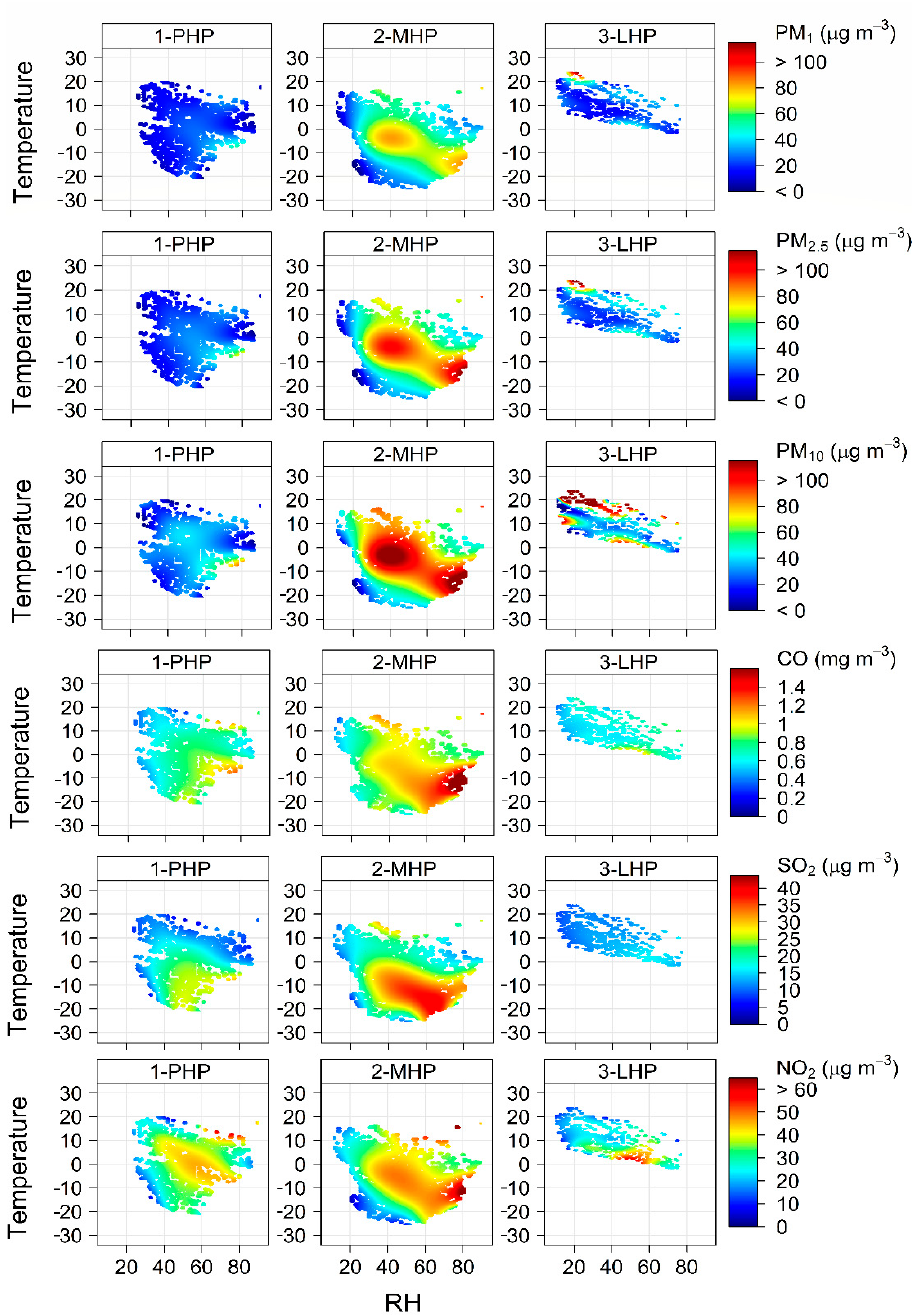
Figure 5. Probability distributions of atmospheric pollutants with relative humidity (RH) and am- temperature (T) during PHP, MHP and bient temperature (T) during PHP, MHP and LHP.